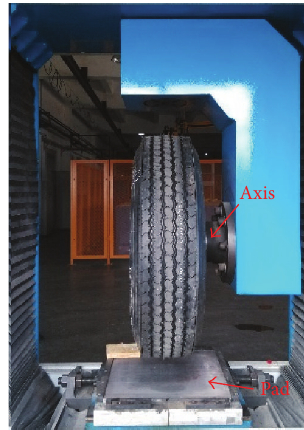
Figure 4: Static loading test.